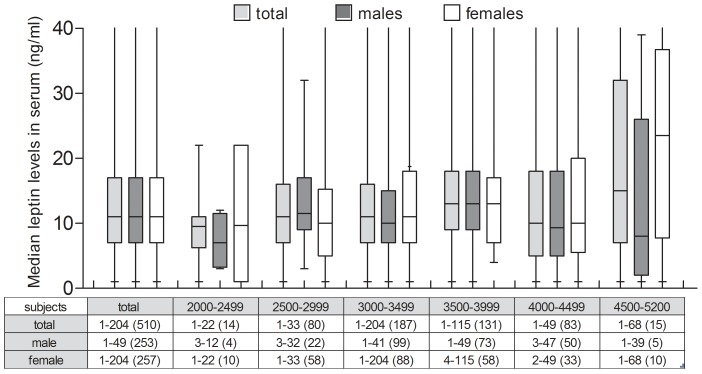
Cord blood leptin levels in healthy neonates categorized by birth weight.Median serum leptin levels in 7 weight categories (g); each includes leptin values for the total sample, male and female infants. The table shows the min. and max. leptin values (ng/ml) and the number of subjects (n) per weight group (total, males, females).